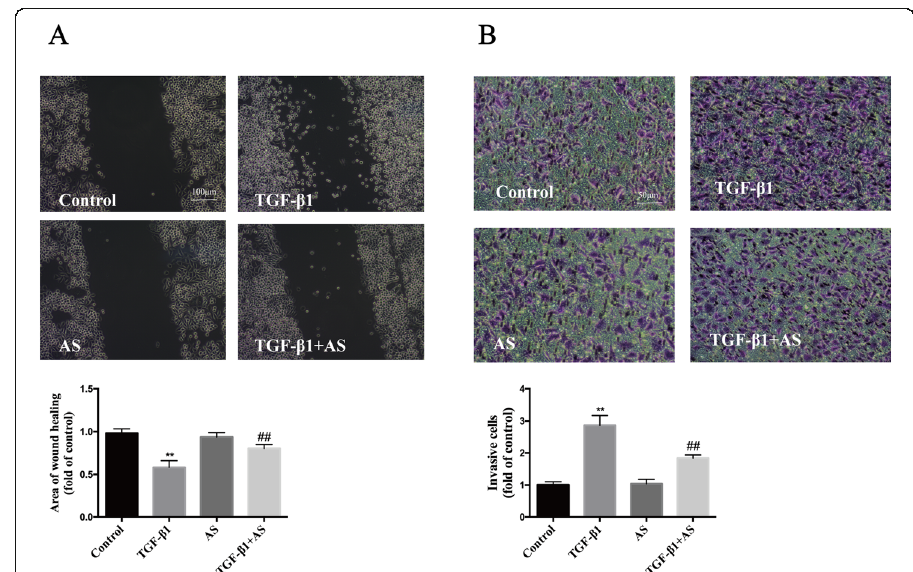
Fig. 4 Effect of asiaticoside on TGF- β 1-induced migration ability of HPMCs. Notes: HPMCs were exposed to asiaticoside (150 μ M) with or without TGF- β 1 (10 ng/cm 3 ) and subjected to microscope to visualize the lateral (A) and longitudinal (B) migration of cells. Quantitative measurements of the fluorescence intensities were conducted using ImageJ software. Five random fields for each insert were counted, and three independent experiments were performed in each group. n = 3. Abbreviations: AS, asiaticoside; TGF- β 1, transforming growth factor- β 1